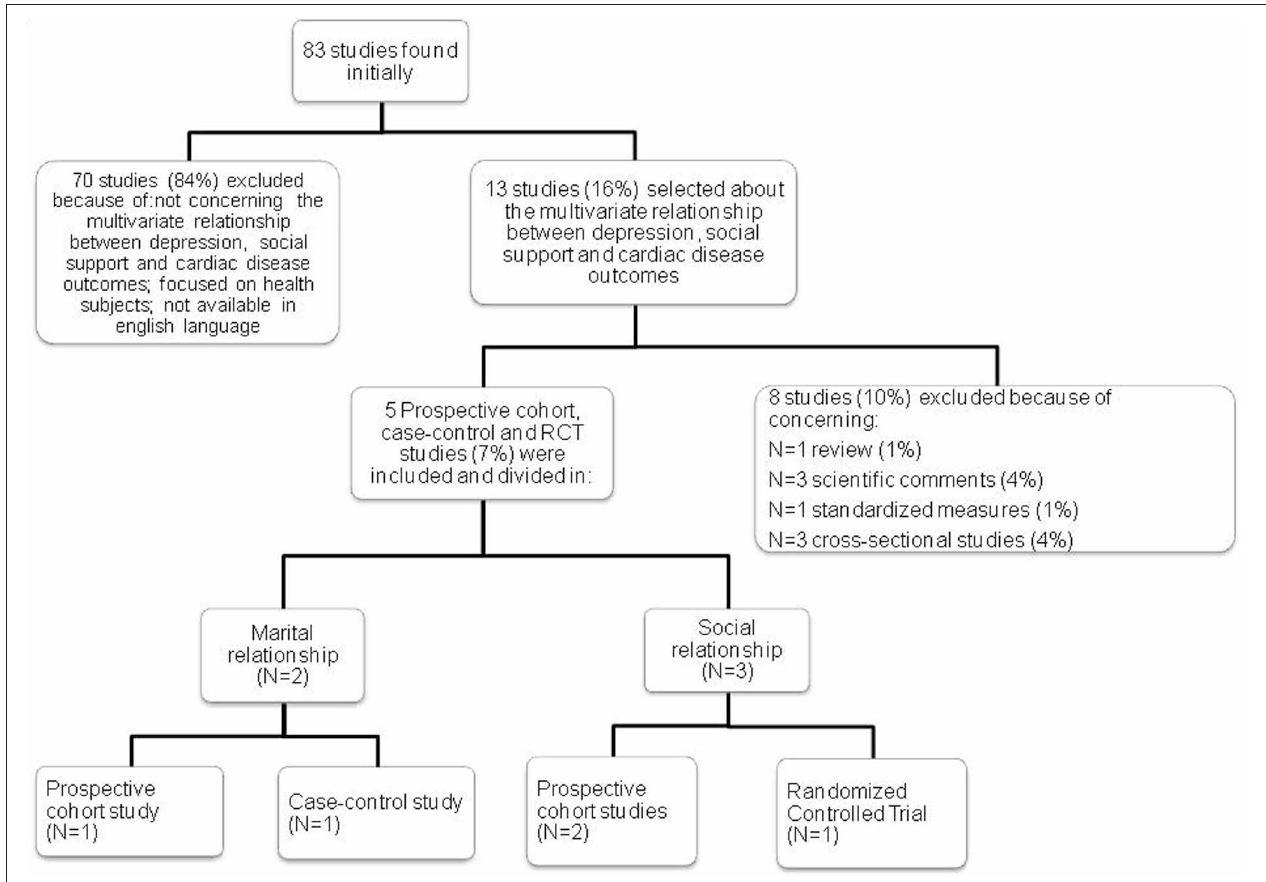
FIGURE 1 | Review Flow